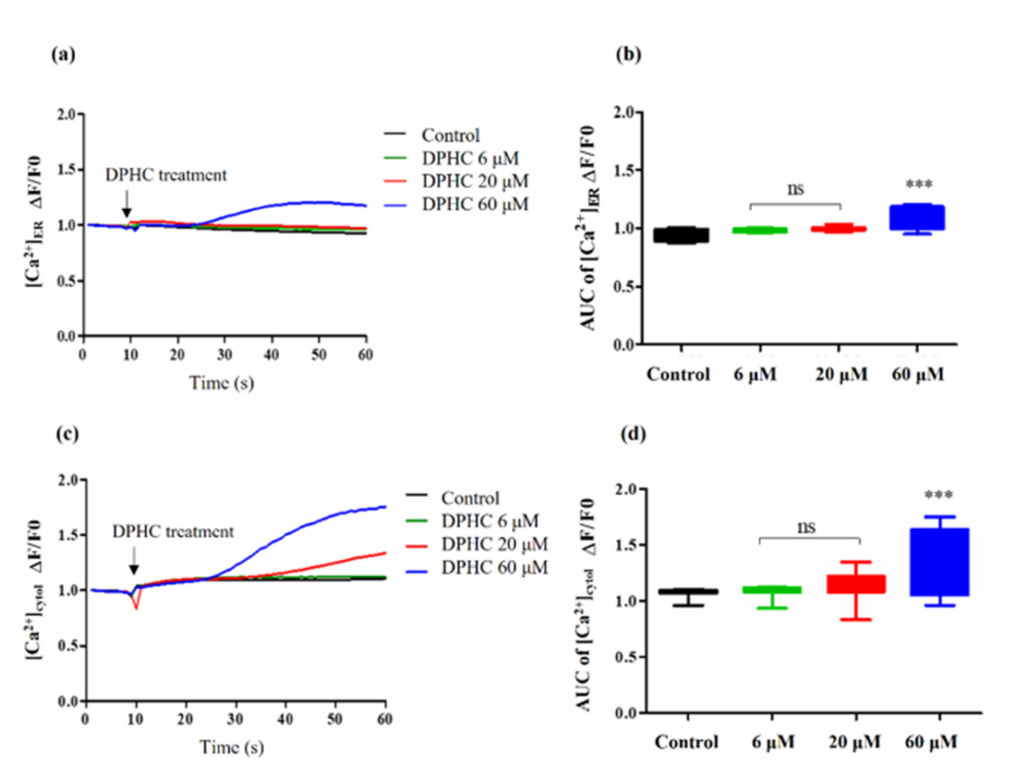
Figure 4. Quantification of the [Ca 2+ ] ER and [Ca 2+ ] cytol levels stimulated by different concentrations of DPHC in EA.hy926 cells. ( a , b ) The traces ( a ) and box plots ( b ) indicating the levels of [Ca 2+ ] ER . ( c , d ) The traces ( c ) and box plots ( d ) indicating the levels of [Ca 2+ ] cytol . For statistical significance, each sample treatment group was compared to the control group. Experiments were performed in triplicates. * p < 0.05, ** p < 0.01, and *** p < 0.001. ns: not significant; AUC: area under the curve; DPHC: diphlorethohydroxycarmalol; [Ca 2+ ] ER : calcium level in the endoplasmic reticulum; [Ca 2+ ] cytol : calcium level in the cytosol; PSS: physiological salt